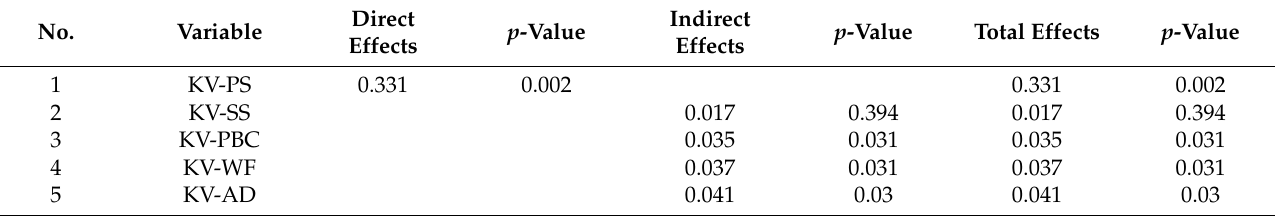
Table 6. Direct, indirect effect, and total